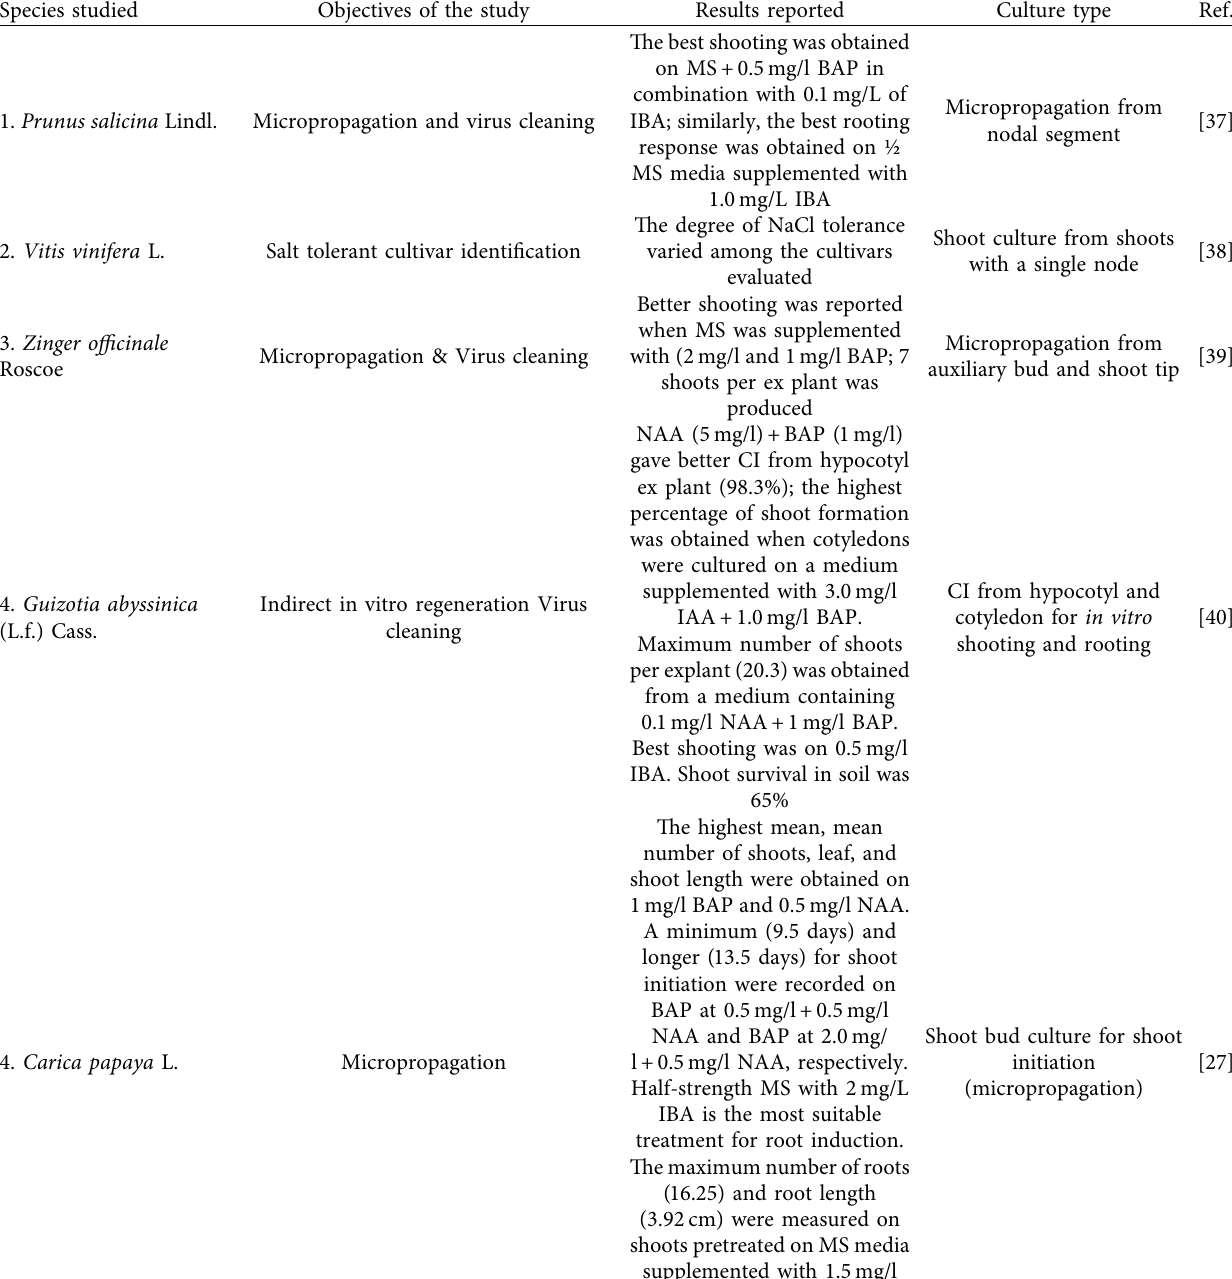
Table 3: Objectives of the study, reported results, and culture types for some representative species studied with their published references. Species studied Objectives of the study